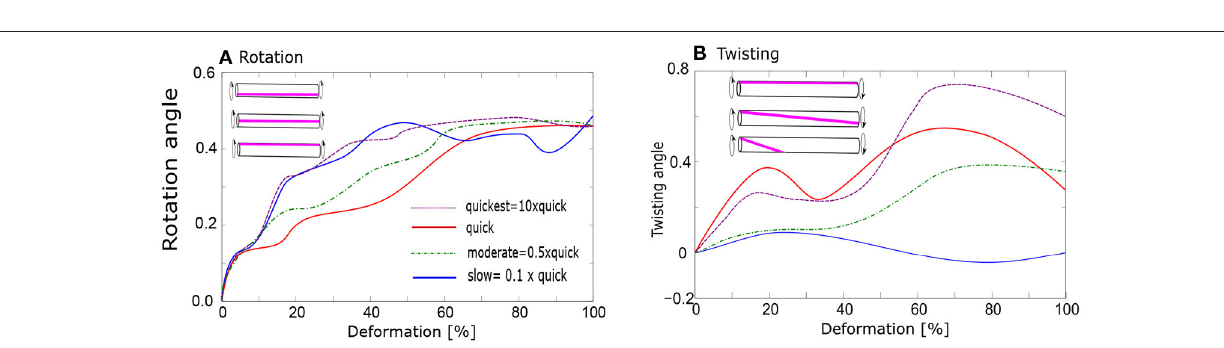
FIGURE 8 | Alignment of chain segments with the fibril axis: An orientational order parameter, P 2 , as function of the chains’ end-to-end distance during relaxation.